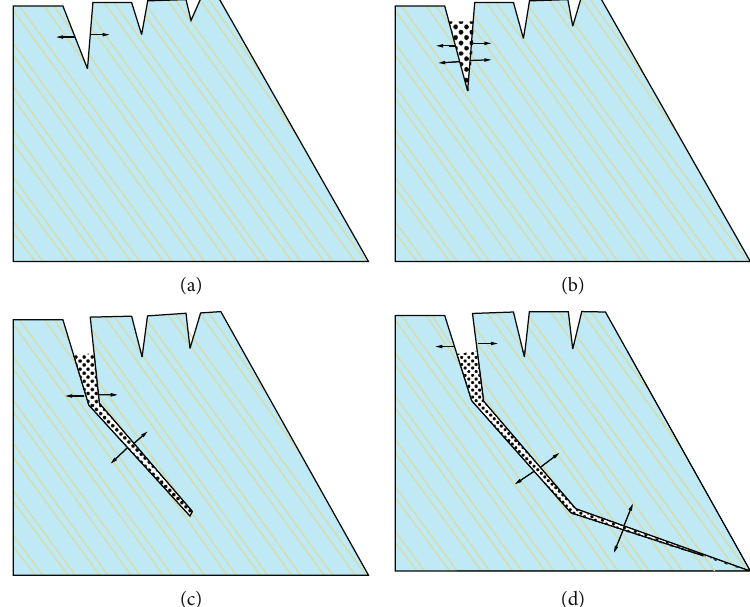
Figure 11: Schematic diagram of pull-apart landslide damage [28]. (a) Severe seismic forces have caused tension cracks in the shoulders of slopes. (b) As the tension cracks expand, debris from the top of the slope rolls into them. (c) Further extension of tension cracks and accumulation of deformation energy in the locking section. (d) The locking section is sheared o ff , the slope is unstable and the landslide is